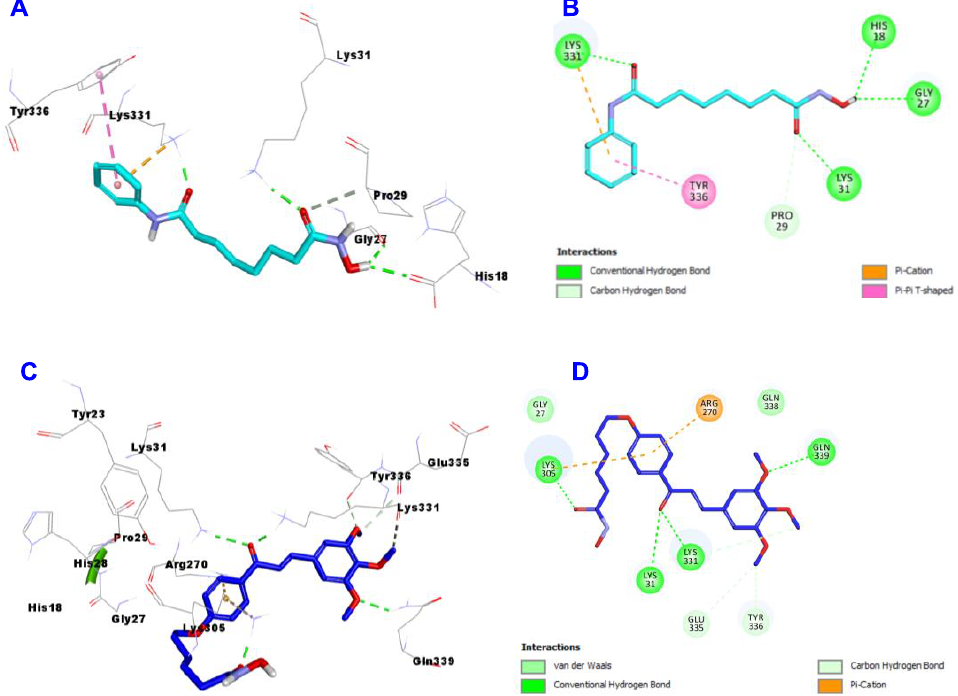
Figure 7 . Docking and binding mode of SAHA (cyan) and 4b (blue) into the active site of HDAC 1 (PDB entry: 5ICN); ( A ) 3D structure of SAHA , ( B ) 2D structure of SAHA, ( C ) 3D structure of 4b , ( D ) 2D structure of 4b .